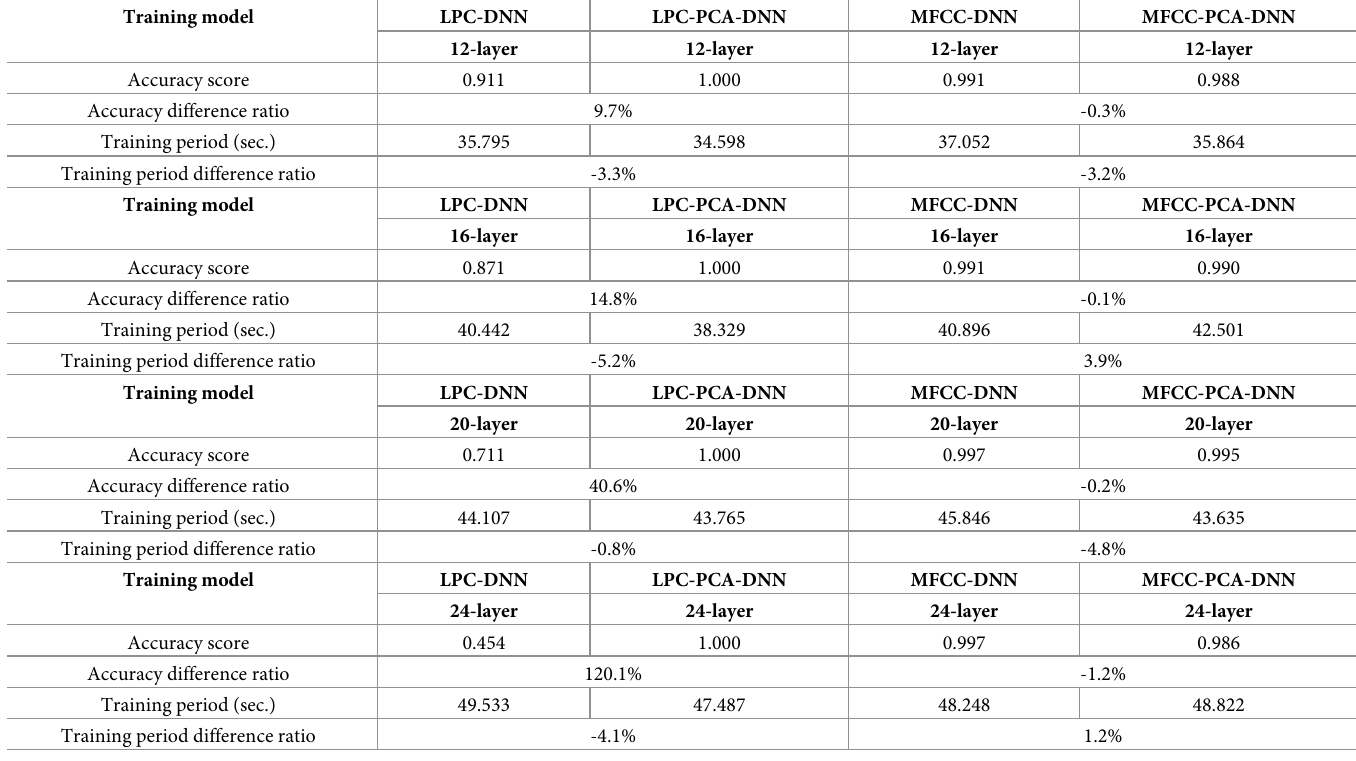
Table 3. Training results of DNN models and PCA-DNN